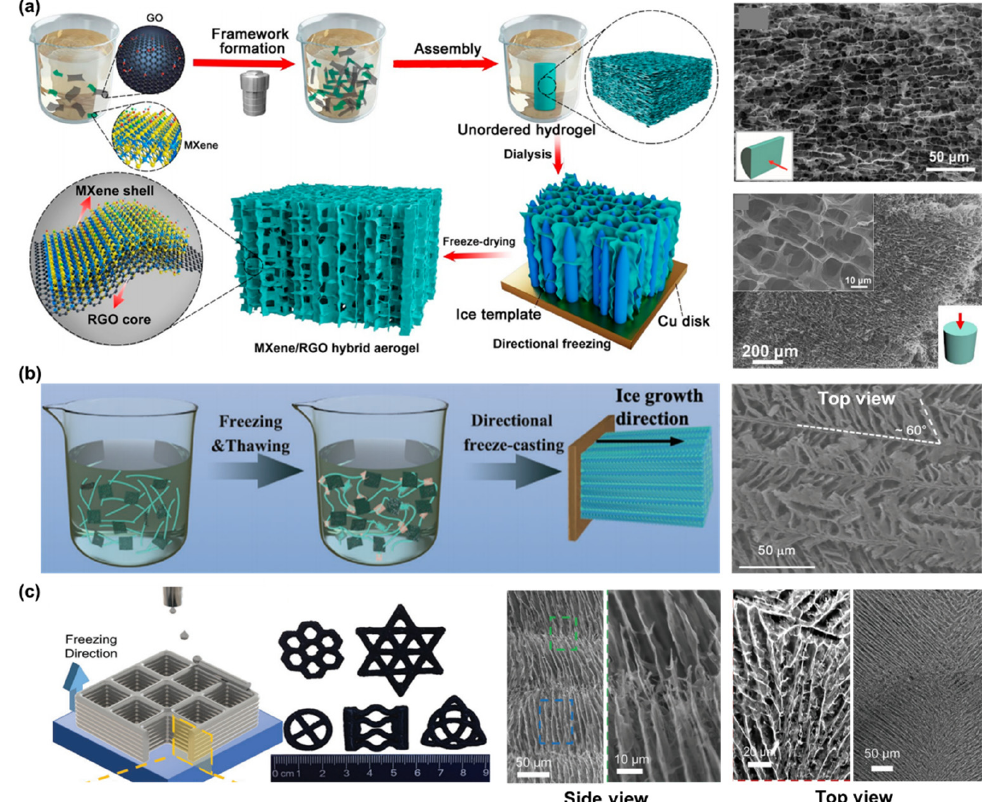
Figure 7. ( a ) Schematic illustration of MXene/rGO aerogel with aligned lamellar microstructure prepared by UFC, and SEM images captured from the side view and top view. ( b ) Schematic illustration of spectrally modified MXene/PVA aerogel with local oriented lamellar structure prepared by freezing/thawing, UFC, and freeze drying, and SEM image captured from the top view of this aerogel. ( c ) Schematic illustration of patterned MXene aerogel prepared by drop-on-demand inkjet printing and UFC, and SEM images captured from the side view and top view of this aerogel. ( a ) is reproduced with permission from ref. [49]. Copyright 2018, American Chemical Society. ( b ) is reproduced with permission from ref. [110]. Copyright 2022, Wiley-VCH. ( c ) is reproduced with permission from ref. [111]. Copyright 2021, Wiley-VCH.